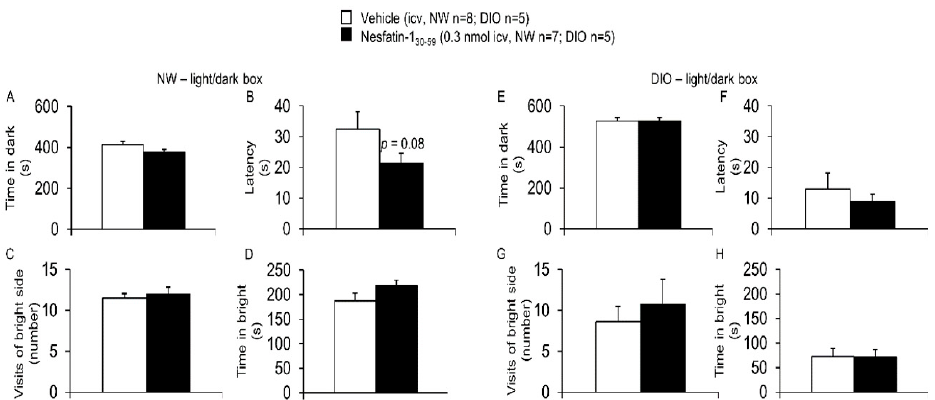
Figure 5. Nesfatin-1 30-59 neither affected the explorative behavior in the light/dark box in normal weight nor in diet-induced obese rats. Intracerebroventricularly cannulated normal weight or diet-induced obese rats were injected with vehicle (5 µ L H 2 O, n = 8 and n = 5, respectively) or nesfatin-1 30-59 (0.3 nmol/rat in 5 µ L H 2 O, n = 7 and n = 5, respectively) at the beginning of the dark phase and 30 min later placed in the bright compartment of the light/dark box. Behavior including time in dark (( A ): normal weight; ( E ): diet-induced obesity), latency to the first entry into the black compartment (( B ): normal weight; ( F ): diet-induced obesity), the number of visits of the bright side (( C ): normal weight; ( G ): diet-induced obesity) and the time in bright side (( D ): normal weight; ( H ): diet-induced obesity) was assessed for 10 min using a computer-supported technique. None of the parameters were affected by intracerebroventricularly injected nesfatin-1 30-59 in any group. All data in the normal weight group were distributed normally. In the DIO group, the parameter latency was not distributed normally in the vehicle group. For better comparability, all data are expressed as mean ± SEM. Data have been analyzed using the Mann–Whitney-U test (latency in DIO) or t -test (all other data). Abbreviations: DIO, diet-induced obesity; NW, normal weight. p > 0.05.